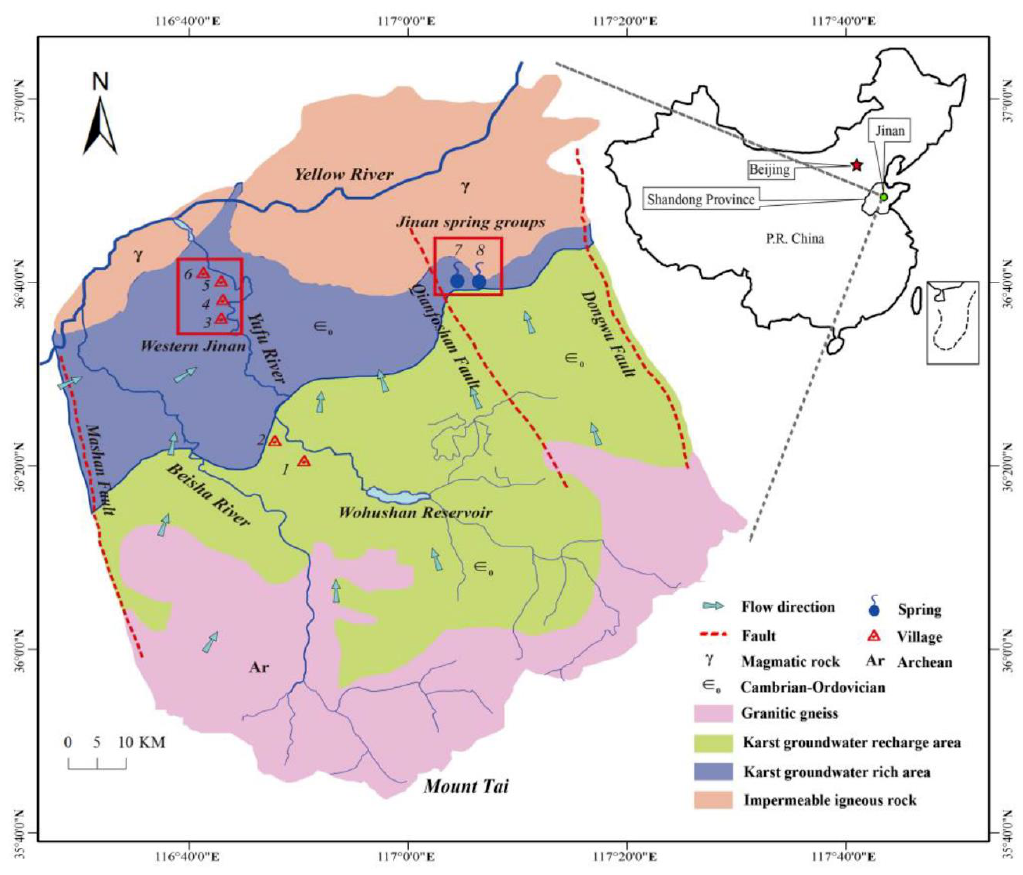
Figure 1. Location map of Jinan spring catchment shows 1—Cuima Village, 2—Yinjialin Village, 3—Dujiamiao Village, 4—Zhuzhuang Village, 5—Nanbali Village, 6—Kuangli Village, 7—Baotu Spring, 8—Black Tiger Spring.